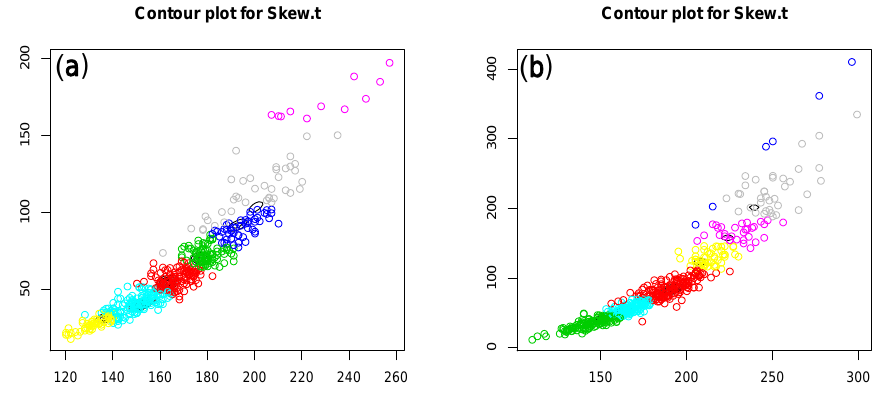
Contour plot for Skew.t